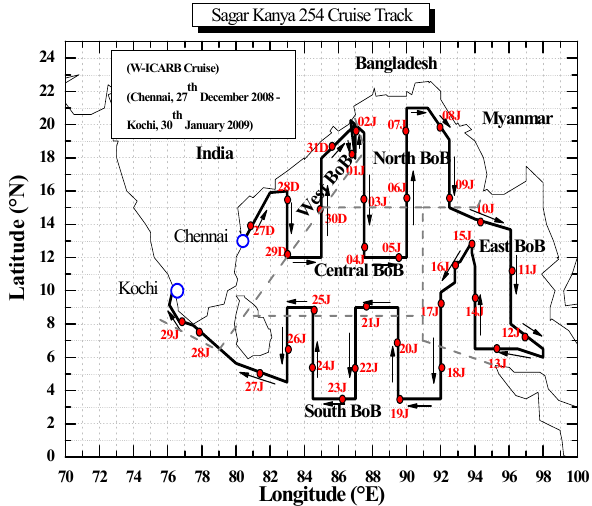
Fig. 1. The cruise track of Sagar Kanya 254 during W-ICARB, 27 December 2008–30 January 2009. The arrow shows the ship’s Figure 1. 5 direction of movement, while the circles the positions of the ship at 6 10:30 LST for each day defined in red next to the circles. The entire BoB is divided in 5 sub-regions, namely (a) west, along the Indian coast, (b) north, (c) east, (d) central, and (e) south.